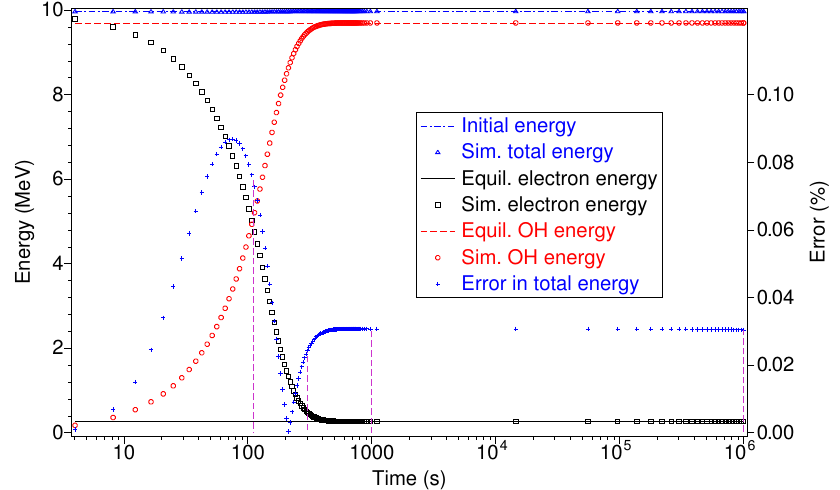
Figure 7. Initial or equilibrium (horizontal lines) and simulated (symbols) energies plotted as a function of time for N = 100. The percentage errors in the total energy are shown by plus signs. Vertical dashed lines indicate the times for which the electron distributions are plotted in Figure